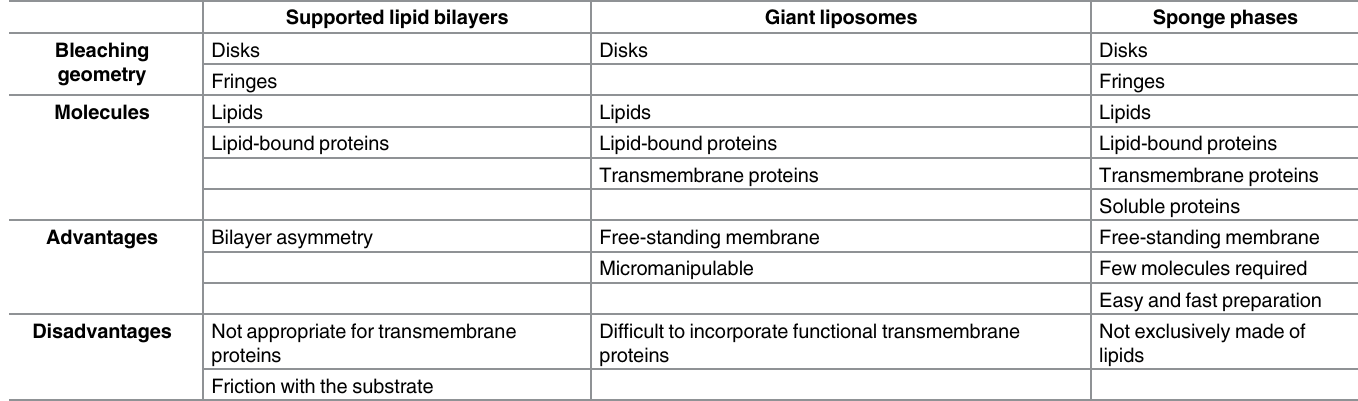
Table 1. Advantages and disadvantages of the various in vitro membrane platforms available to study FRAP by confocal microscopy. Supported lipid bilayers Giant liposomes Sponge